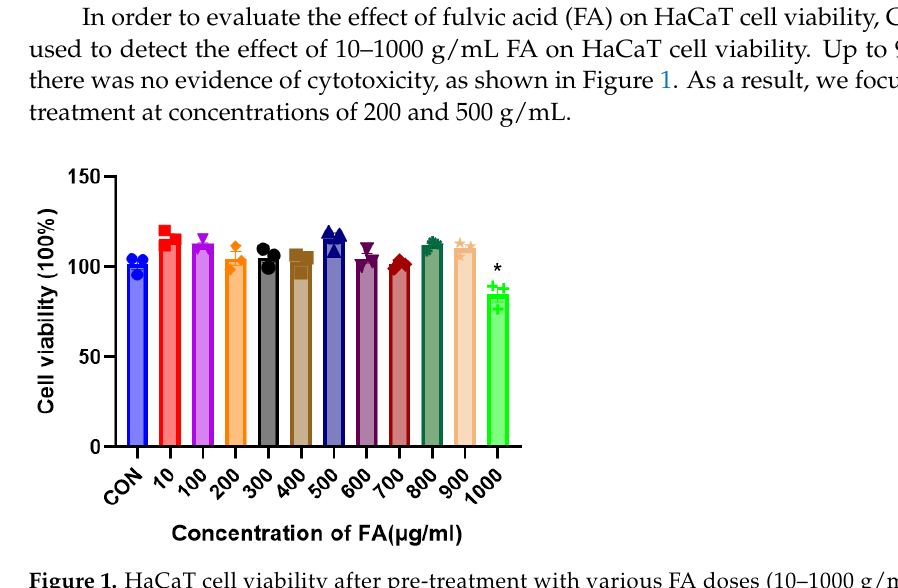
Figure 1. HaCaT cell viability after pre-treatment with various FA doses (10–1000 g/mL). HaCaT cells received different FA doses for 24 h at 37 °C and 5% CO 2 . A minimum of three experiments were used to calculate the mean ± SEM. Compared with the CON group, * p < 0.05, ns stands for not significant.